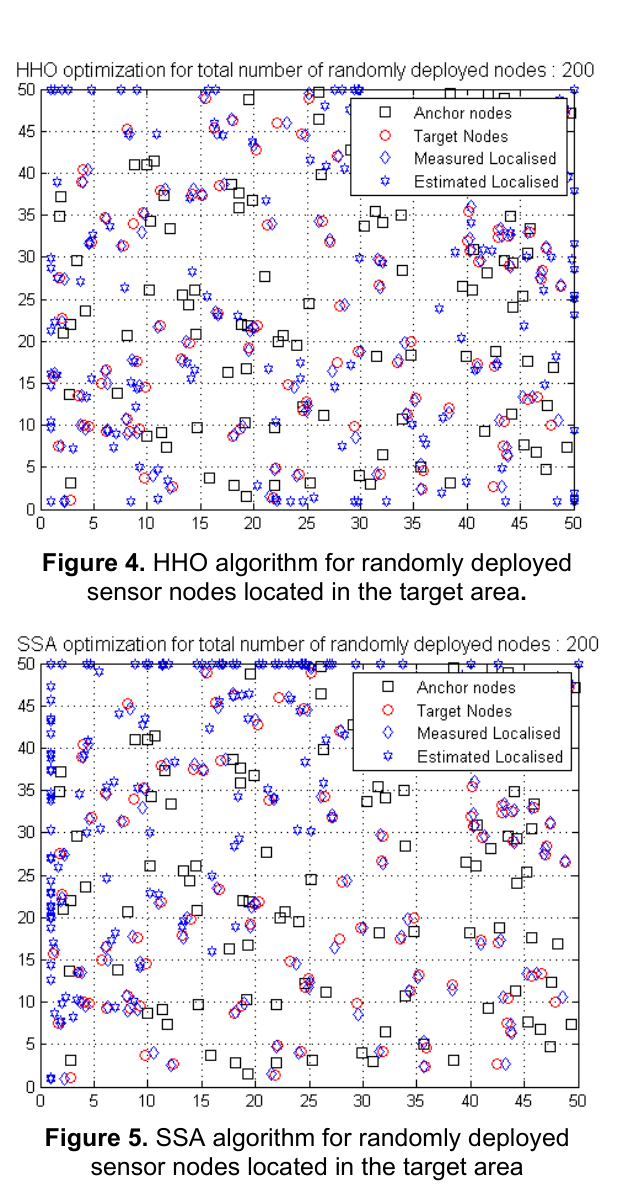
Figure 7. EO algorithm for randomly deployed sensor nodes located in the target